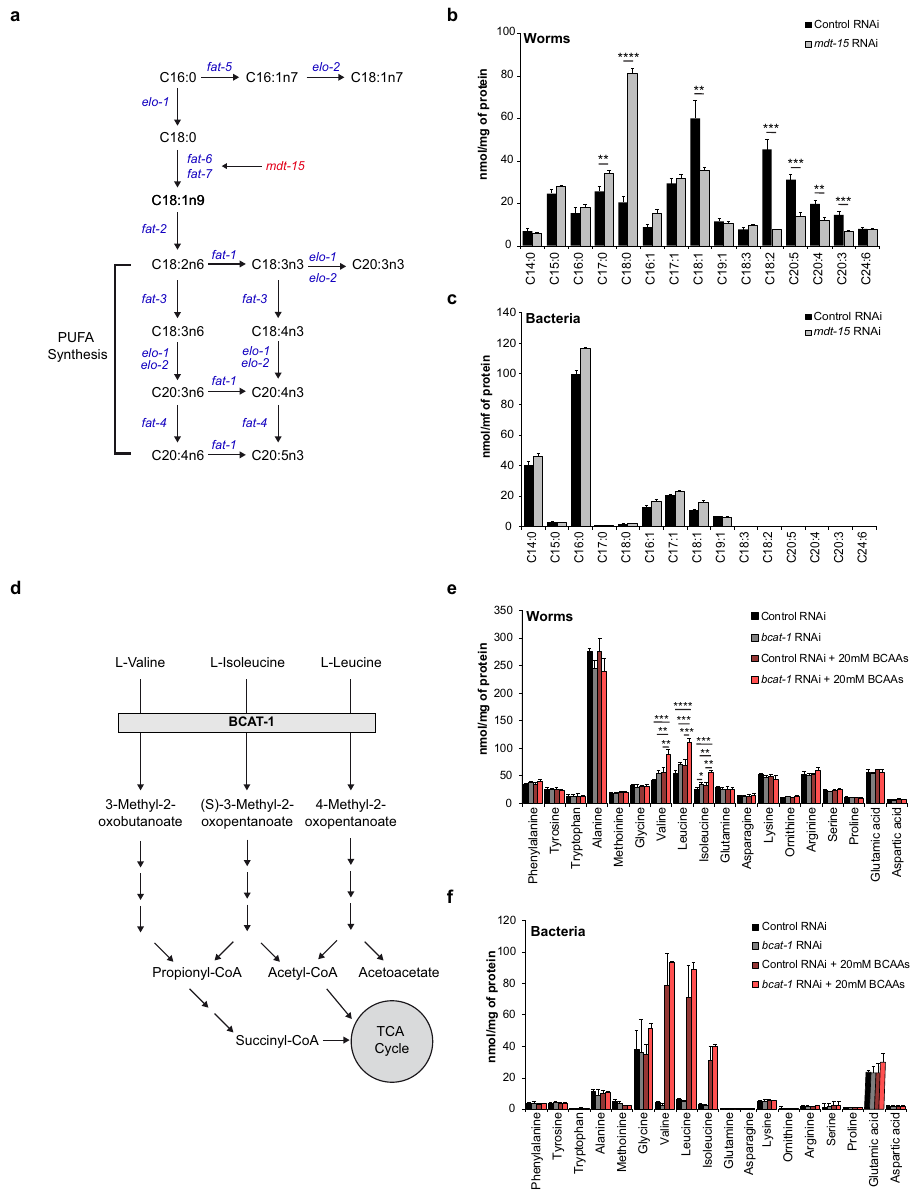
Figure 2. Validation of FA and AA analysis in C. elegans with deficient lipid or AA metabolism. ( a ) Schematic representation of polyunsaturated fatty acid (PUFA) synthesis pathway in C. elegans . mdt-15 is a key regulator in this pathway that controls the activity of stearoyl-CoA desaturases fat-6 and fat-7 . ( b ) N2 worms exposed to mdt-15 RNAi accumulated C18:0 and had reduced levels of C18:1 and PUFAs. Bar graphs are expressed as mean ± SD; Significance was calculated using Student’s t -test. * p ≤ 0.05; ** p ≤ 0.01; *** p ≤ 0.001; **** p ≤ 0.0001. ( c ) FA composition in mdt-15 RNAi bacteria was similar to that in the control RNAi bacteria. No PUFAs were detected in either RNAi bacteria. ( d ) Schematic representation of branched-chain amino acid (BCAA) catabolism. Branched-chain amino acid aminotransferase 1 ( bcat-1 ) catalyzes the first reaction of this pathway. ( e ) Accumulation of BCAAs valine, leucine and isoleucine was detected in rrf-3(pk1426) worms treated with bcat-1 RNAi. Worms grown on plates supplemented with 20 mM BCAAs accumulated BCAAs, which was more pronounced in combination with bcat-1 RNAi. Bar graphs are expressed as mean ± SD, Significance was calculated using One-way ANOVA; * p ≤ 0.05; ** p ≤ 0.01; *** p ≤ 0.001; **** p ≤ 0.0001. ( f ) BCAAs levels were similar in control and bcat-1 RNAi bacteria, but accumulated in BCAA-supplemented bacteria. See also Supplementary Fig.